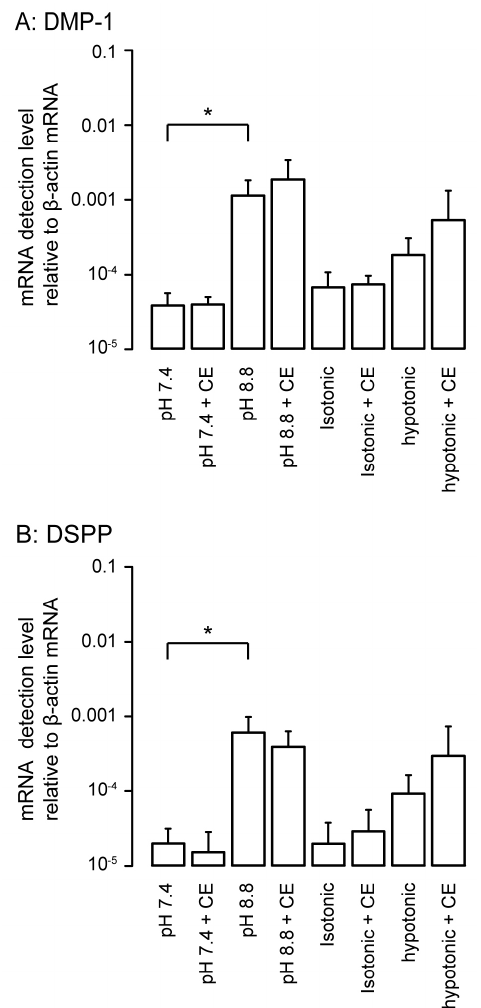
Figure 7. The changes in mRNA level of dentin matrix protein-1 (DMP-1) ( A ) and dentin sialophos- phoprotein (DSPP) ( B ) as markers specific for odontoblasts in response to high-pH or hypotonic stimulation with or without CE in HOB cells. Real-time RT-PCR was used to quantify mRNA levels by measuring the increase in fluorescence elicited by the binding of SYBR green dye to double-stranded DNA. Data were analyzed by the 2 − [ ∆∆ Ct] method, with β -actin as an internal control (which was positive in all samples). Each bar denotes the mean ± SE of 5 experiments under physiological or high-pH condition and 3 experiments for isotonic or hypotonic conditions. The levels of mRNA were normalized to β -actin mRNA levels. Statistically significant differences between columns (Shown by solid lines) are marked with asterisks. * P < 0.05.